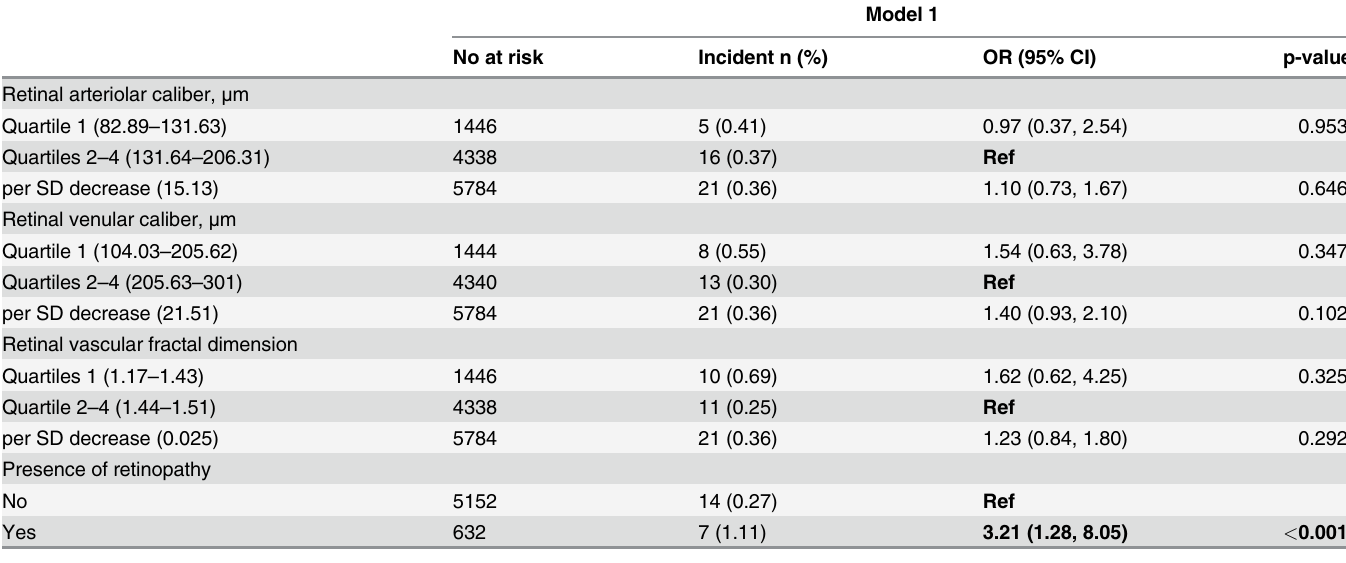
Table 3. Relation of retinal vascular caliber, retinal vascular fractal dimension and retinopathy signs to prevalent end stage renal disease.